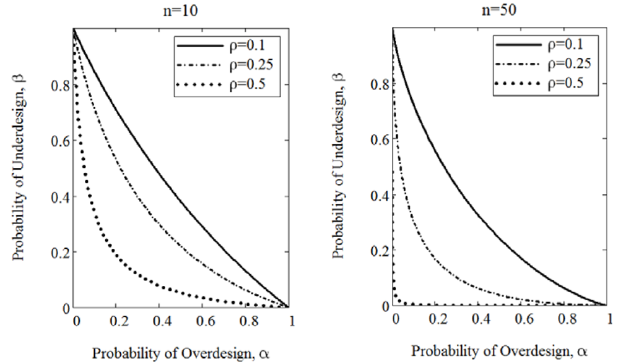
Fig. 2. Relationship between probability of societal under- and over- preparedness, β and α , respectively, as a function of the goodness- of-fit of the trend model ρ , and the length of record n , used to fit the trend